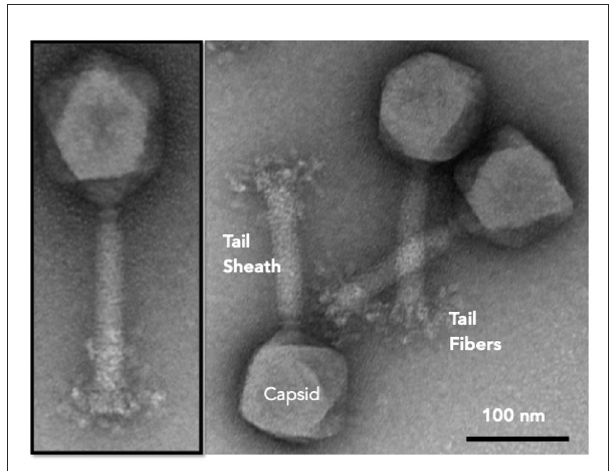
FIGURE1 DET7 bacteriophage showing polyhedral capsid, tail sheath, and tail fibers with recognition proteins that attach to specific